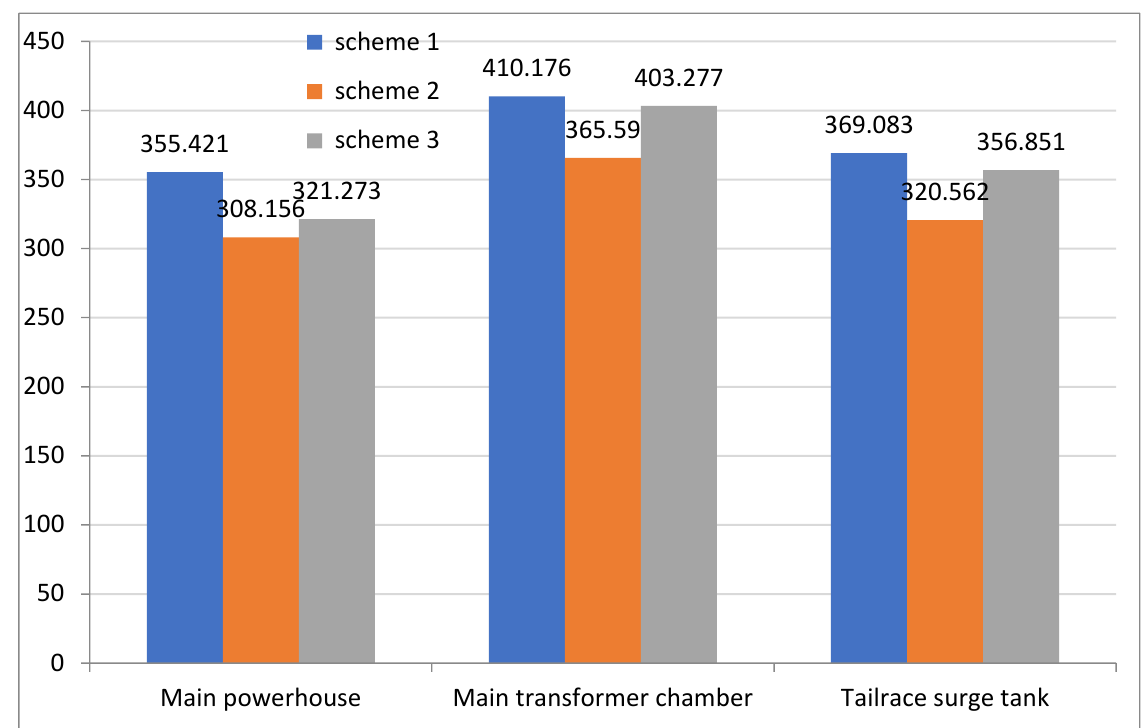
Figure 14. Vertical displacements (mm) of the arch of cavern group in three schemes after excavation completion.